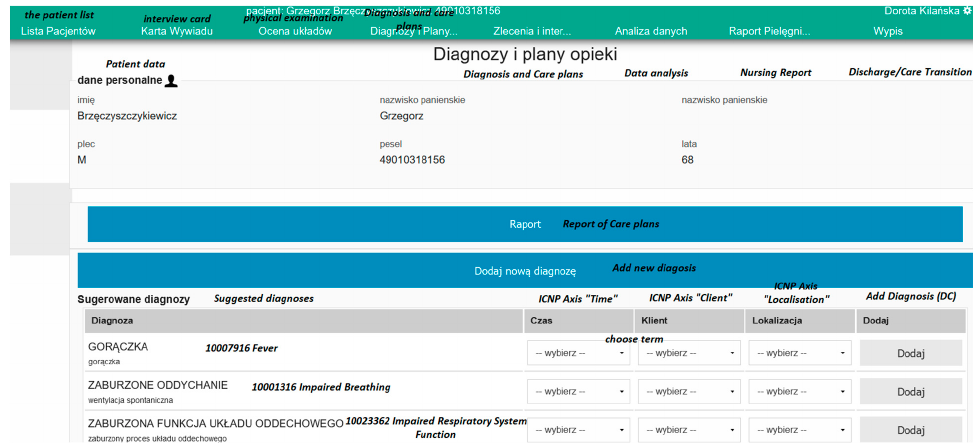
Figure 5. An example set of diagnoses for a patient enabling establishing the time, location of the problem; source: https://pielegniarki.umed.pl/diagnozy.html (accessed on on 19 April 2022).